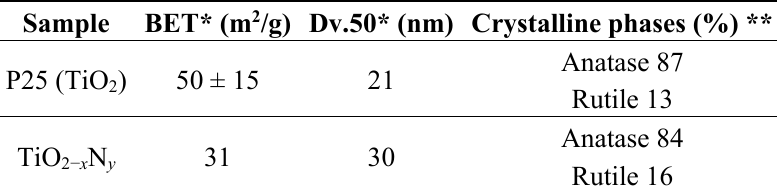
Table 1. Characteristics of nanoparticles